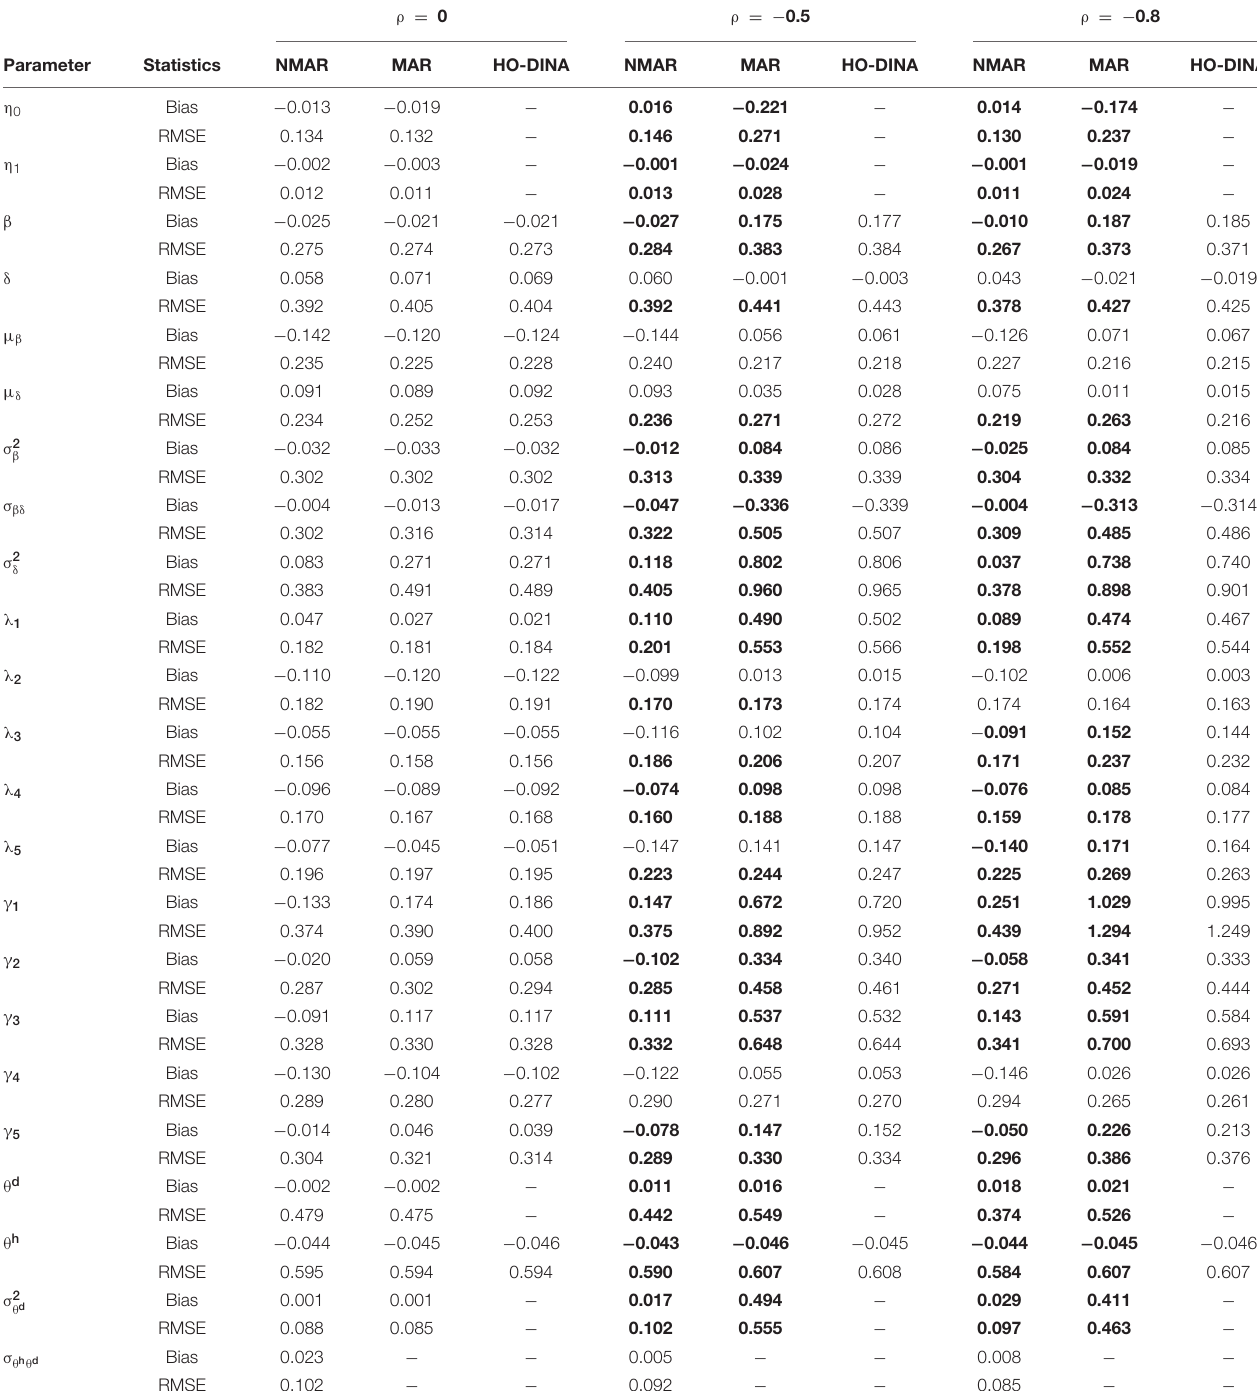
TABLE 5 | Bias and RMSE of parameter estimates of three models with high dropping-out proportion under different correlations between θ h i and θ d i in simulation study III. ρ = 0 ρ = − 0.5 ρ = −